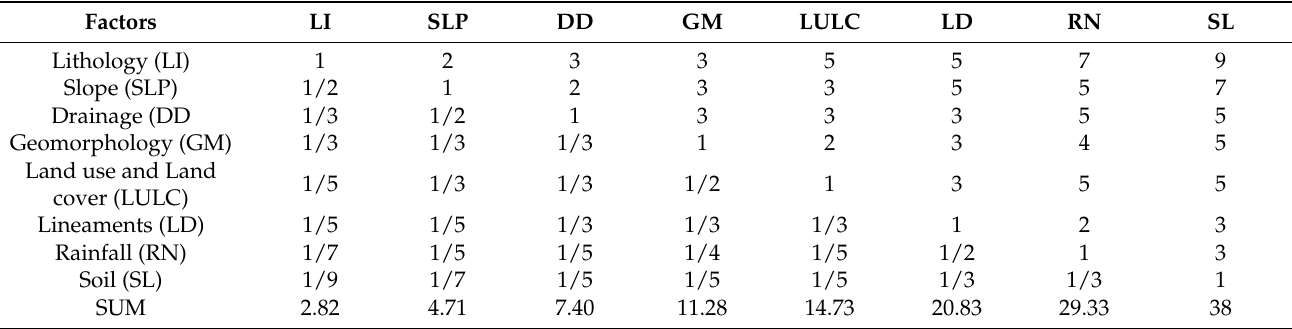
Table 3. Pairwise comparison matrix for all factors.